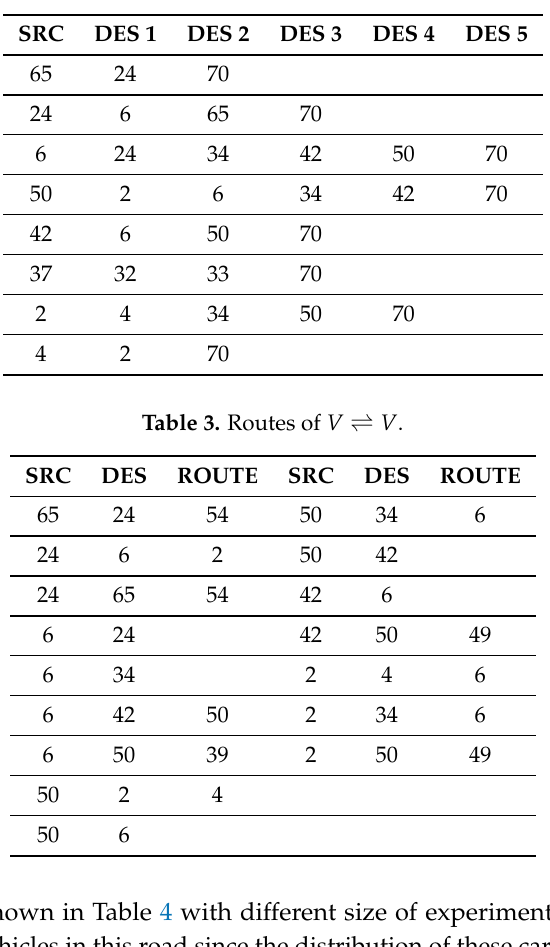
Table 4. Number of Route Hops for V (cid:42)(cid:41) V as The Number of Vehicles Increases.